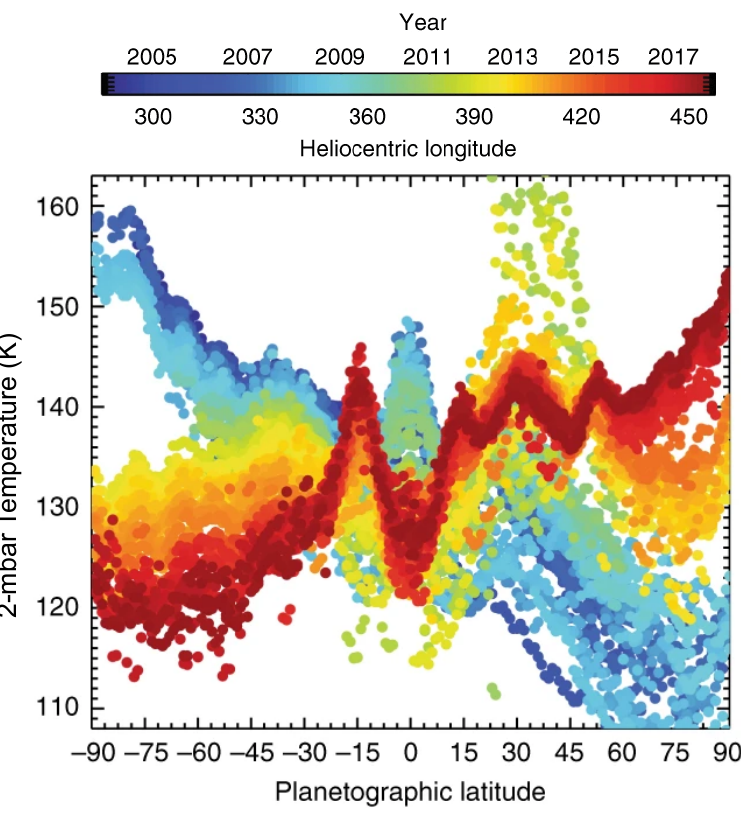
Figure 18. Retrieved temperatures of Saturn’s stratosphere at 2 mbar versus latitude over the entire Cassini mission, adapted from Fletcher et al. [78]. The years and heliocentric longitudes–indicating the seasonal phase, with 270 and 360 marking the northern winter solstice and spring equinox, respectively–are indicated by the color